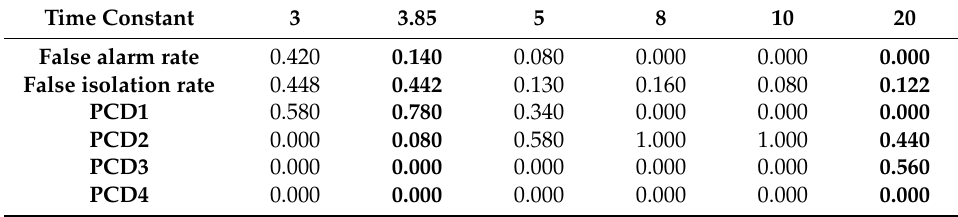
Table 7. The relationship between time constant and the effect on detecting faults (square wave